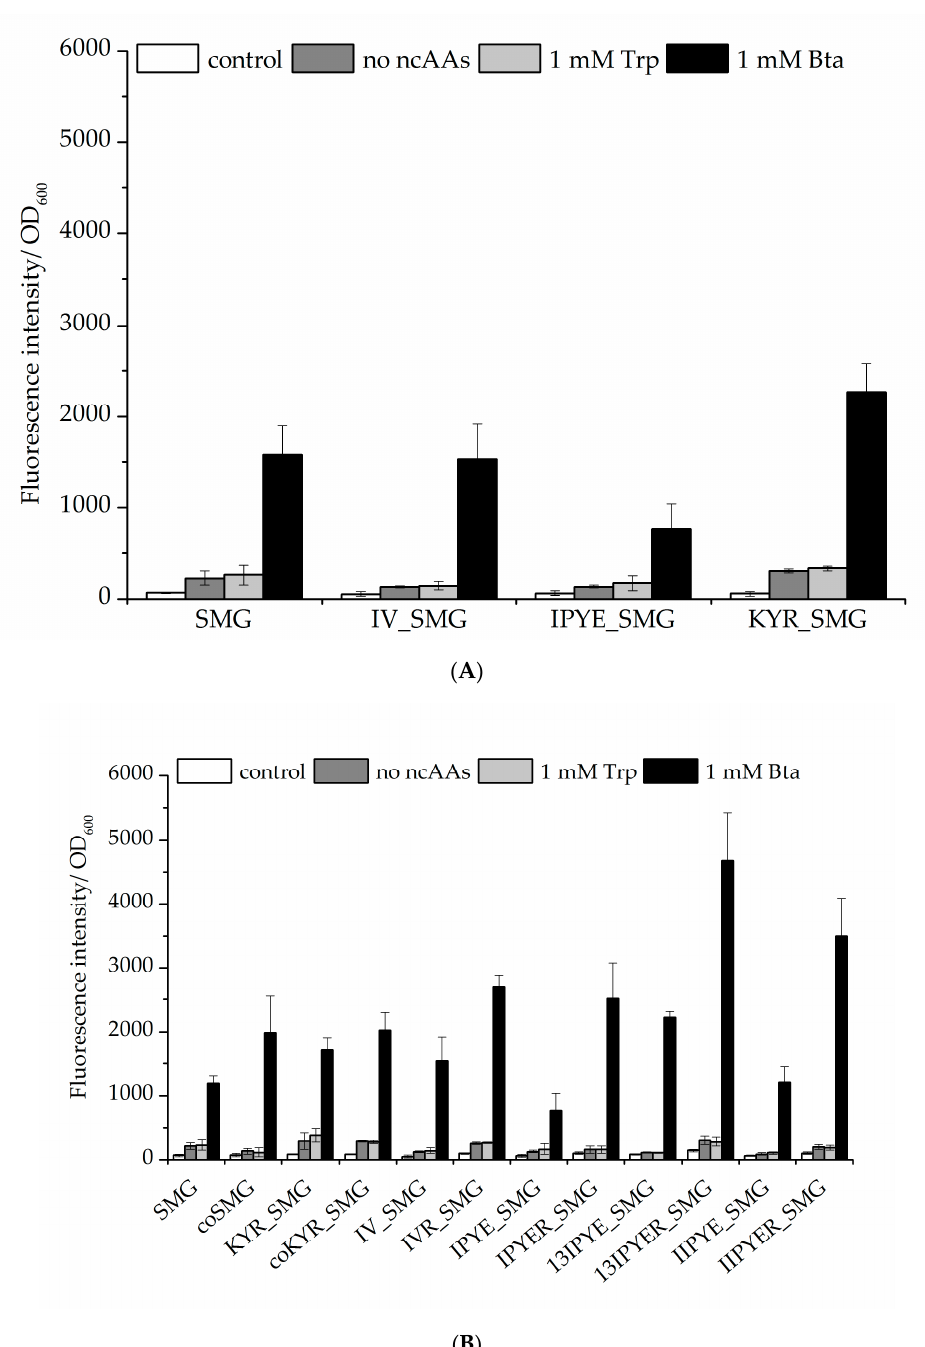
Figure 5. Comparison of Bta incorporation efficiency. Fluorescence of the sfGFP–R2TAG reporter construct arises from amber suppression mediated by different Mm PylRS–SMG variants. ( A ) Mm PylRS–SMG variants combined with activity improving mutation sets introduced by site-directed mutagenesis. According to the observed total cell fluorescence, variant Mm PylRS–KYR_SMG led to the production of more full-length sfGFP compared to other aaRS constructs. ( B ) Mm PylRS–SMG variant performance when combined with different sets of efficiency-improving mutations. Ideally, aaRS construct expression should lead to a low background signal in the absence of ncAA supplementation (no ncAAs controls) and high efficiency Bta incorporation (observed by fluorescence intensity) when the ncAA is supplied. The control setup is without induction and ncAA supplementation; the no-ncAAs setup is with IPTG induction but without Trp or Bta supplementation, respectively. Data are means ± SD ( n =